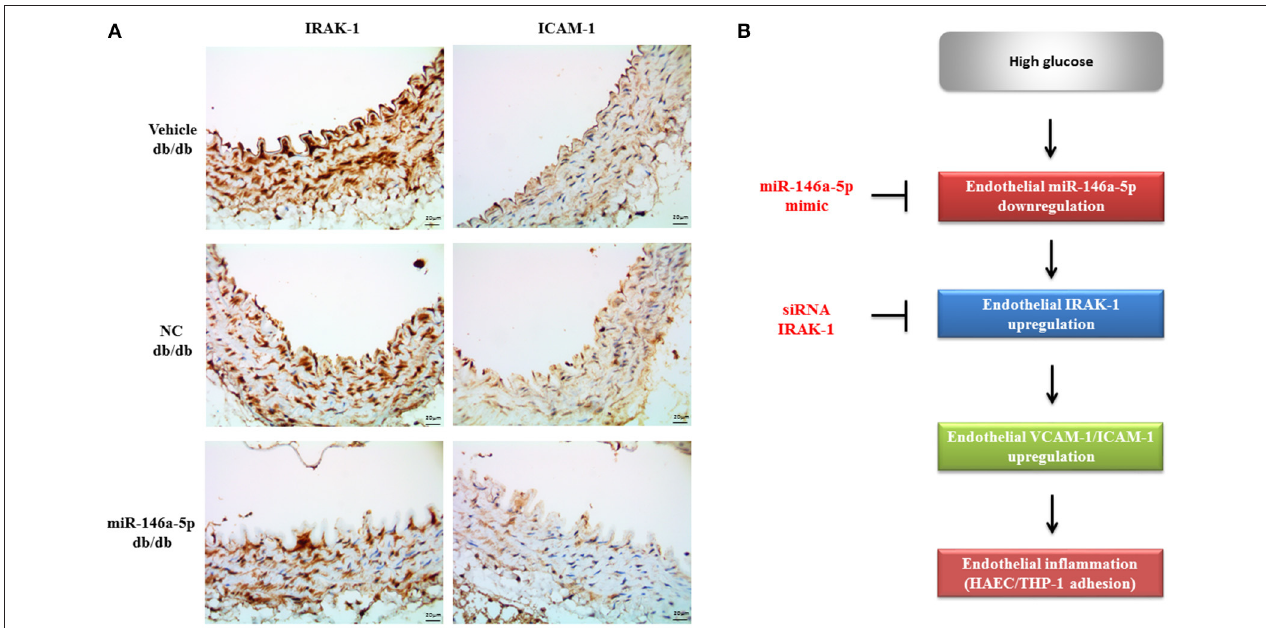
FIGURE 5 | (A) The miR-146a-5p mimic decreased endothelial IRAK-1 and ICAM-1 expression in type 2 db/db diabetic mice. Immunohistochemistry of IRAK-1 and ICAM-1 in thoracic aorta tissue. Representative images showed that the immunoreactivities (brown color) of IRAK-1 and ICAM-1 in endothelial cells were dramatically decreased in the miR-146a-5p mimic-treated diabetic mice, compared to the negative control (NC) or vehicle-treated mice. n = 3 per group. Scale bar = 20 µ m. (B) The proposed role of miR-146a-5p in regulating HG-induced endothelial inflammation via IRAK-1.